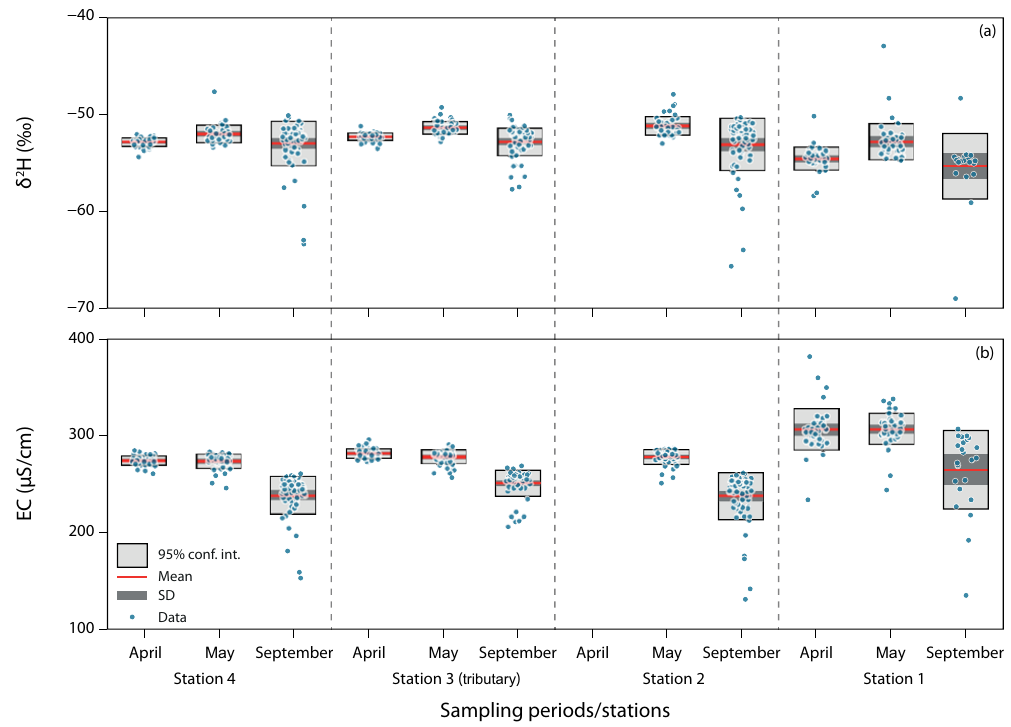
Figure 6. Variability in tracer values measured during event sampling of stream water. (a) δ 2 H and (b) EC values measured in the stream water during the events at the four